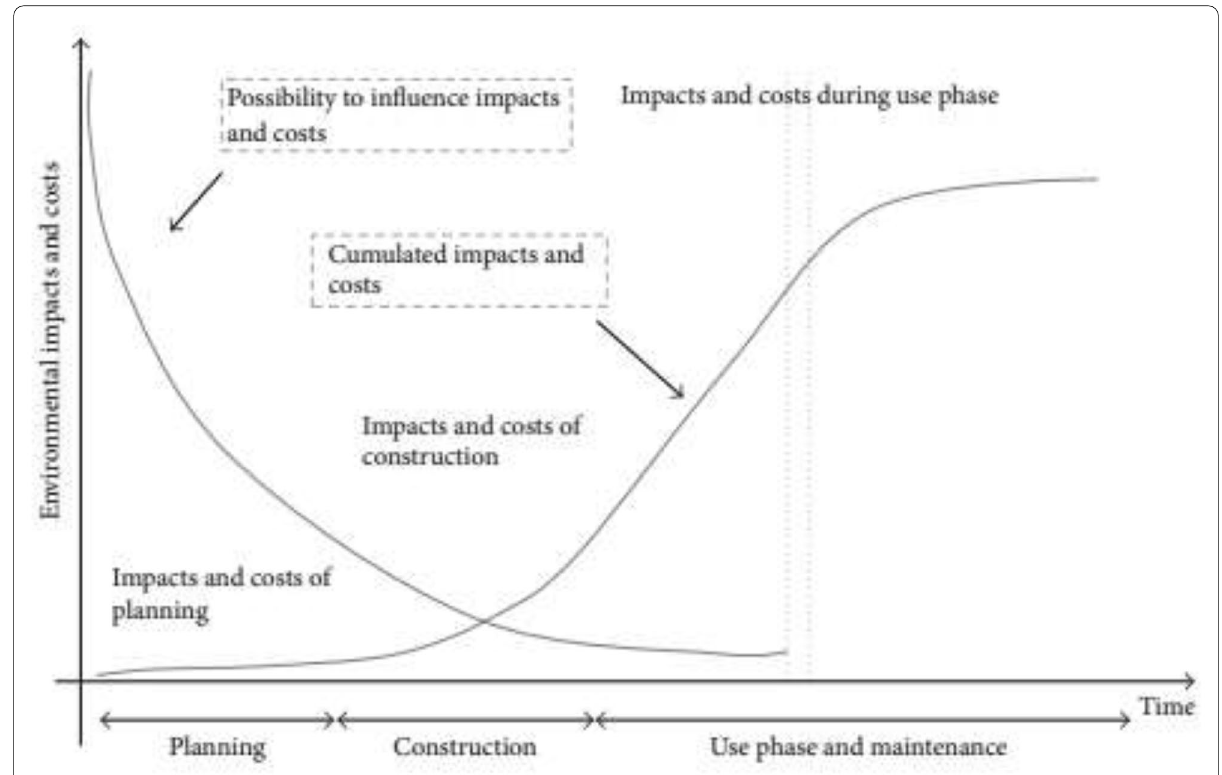
Fig. 12 Influence of design decisions on life cycle impacts and costs. Source: Kohler and Moffat